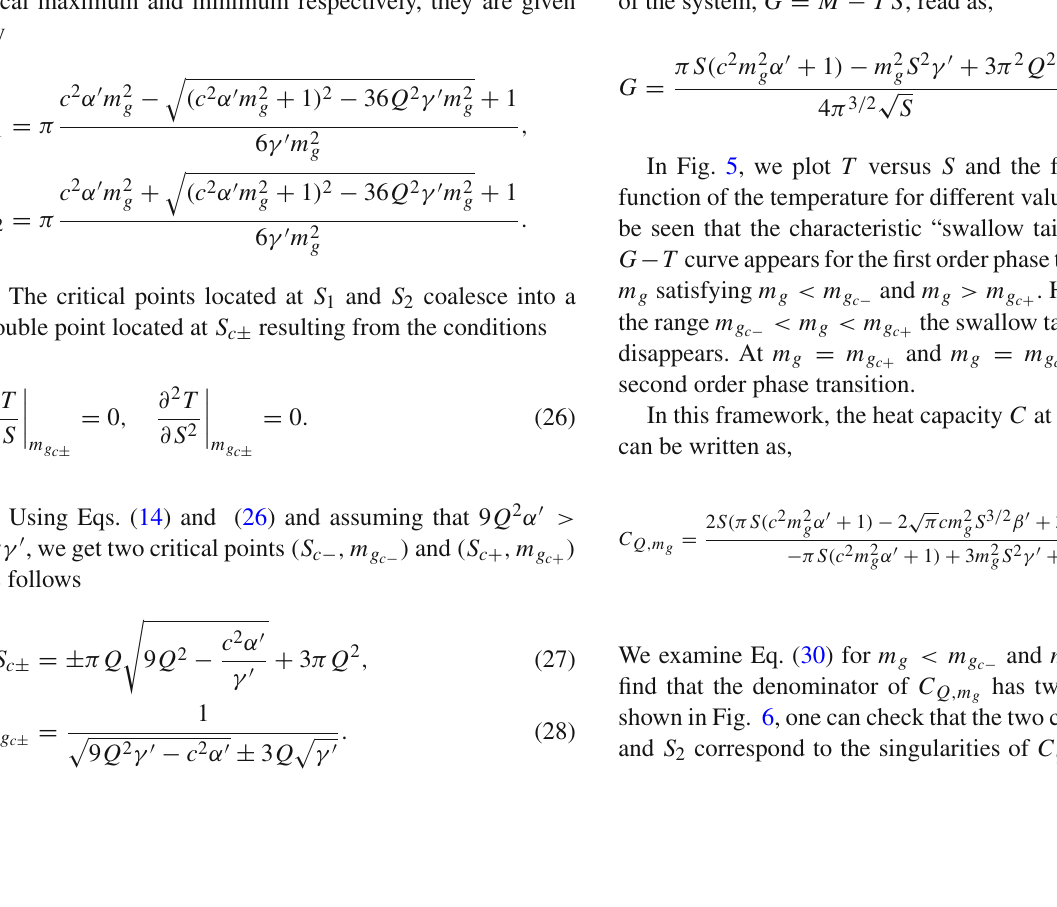
, there are two divergent points, c + , the red lines correspond to the critical g